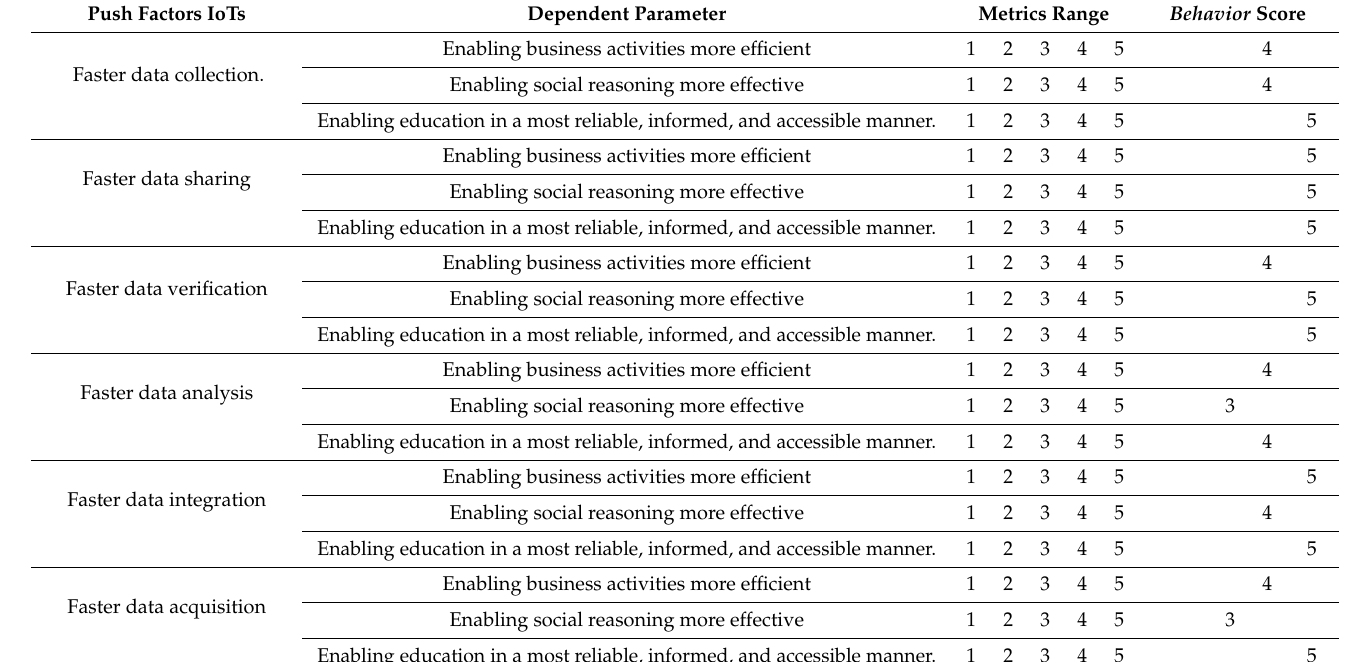
Table 2. Behavior-oriented drive and influential function of IoTs on Customers. Push Factors